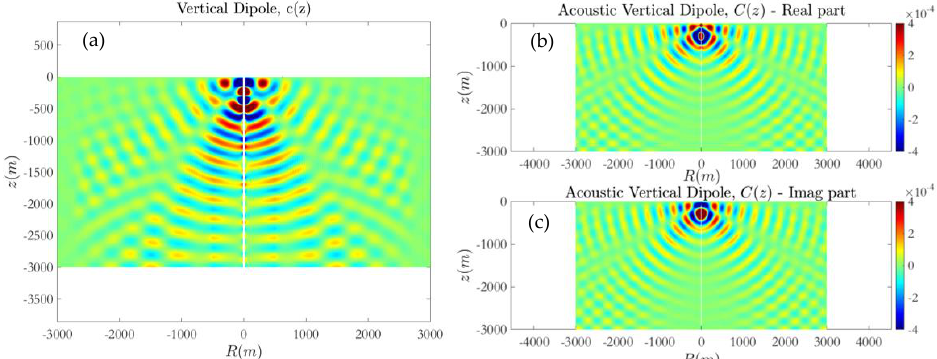
5 f Hz = located at a depth of 300 m in the stratified velocity environment. located at a depth of 300 m in the stratified velocity environment.